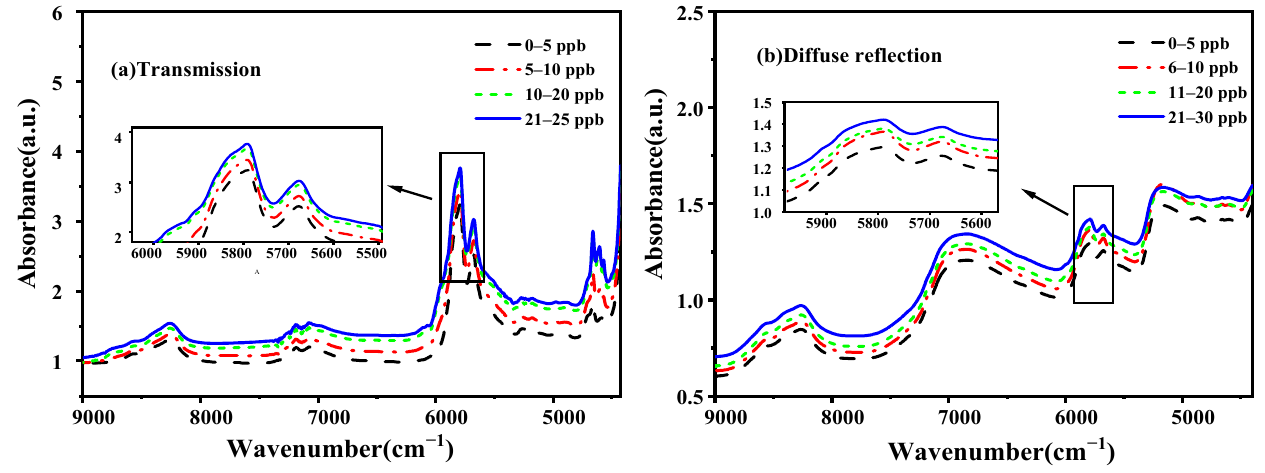
Figure 2. Average FT-NIR spectra of the positive samples.